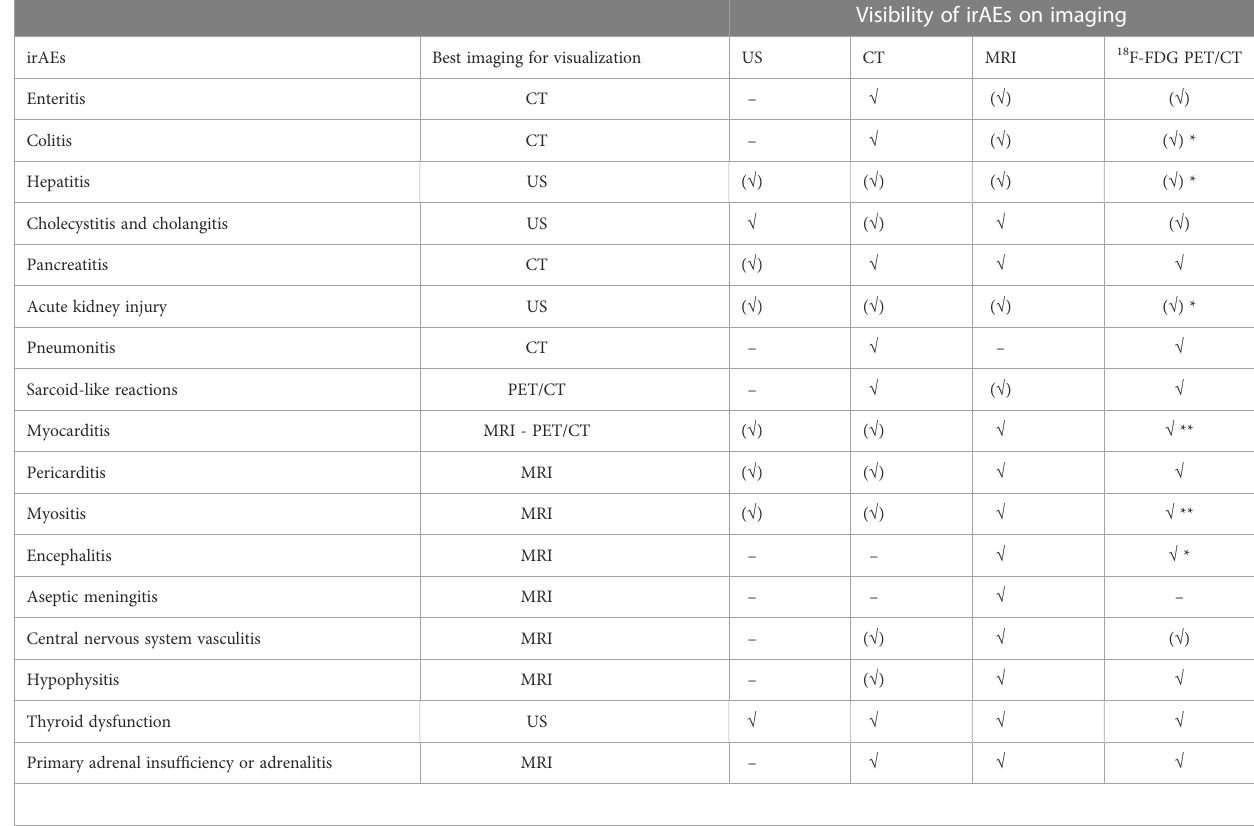
TABLE 3 Visibility of immune-related adverse events (irAEs) on